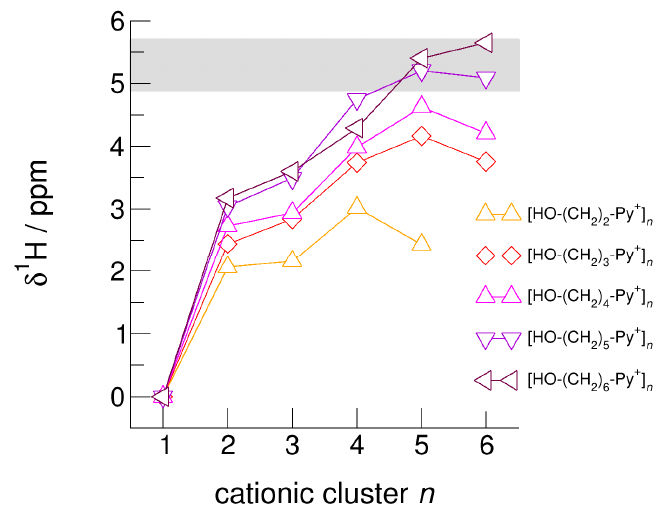
Figure 9. Calculated average NMR proton chemical shifts, δ 1 H, of the hydroxyl protons for the cationic clusters [HO-(CH 2 ) 2 -Py + ] n , [HO-(CH 2 ) 3 -Py + ] n , [HO-(CH 2 ) 4 -Py + ] n , [HO-(CH 2 ) 5 -Py + ] n , and [HO-(CH 2 ) 6 -Py + ] n related to the corresponding monomer values. For comparison, we added the δ 1 H OH chemical shifts of liquid methanol in the temperature range between 200 K ( δ 1 H = 5.7 ppm) and 300 K ( δ 1 H = 4.9 ppm) as indicated by the grey area [64].